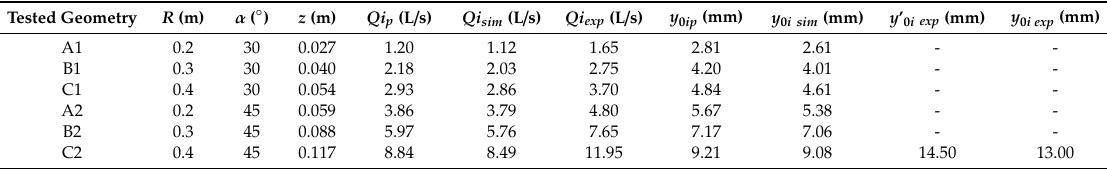
Table 8. The flow rate for the initiation of the jet flow and the flow depth at the lowest point of the flip bucket are